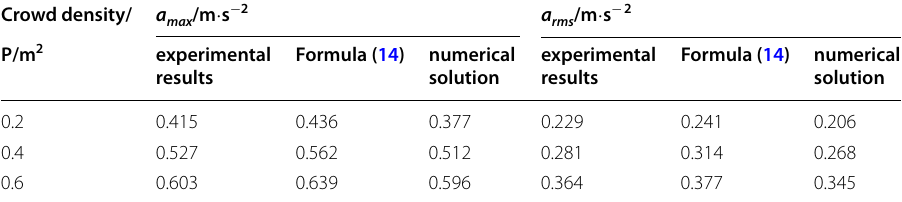
Table 2 Comparison between experimental results and two calculation results Crowd density/ a max /m s − ·